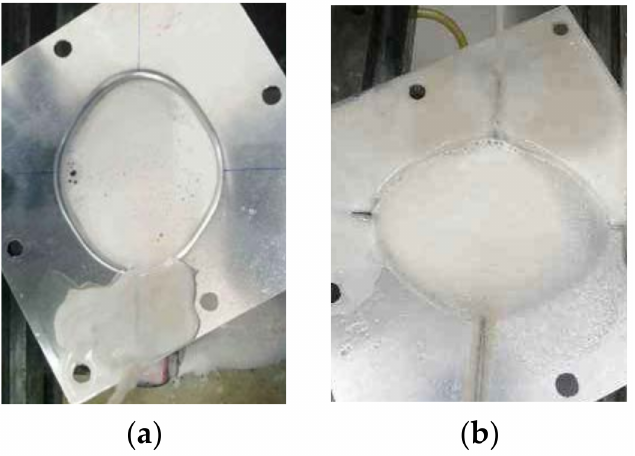
Figure 23. Cutting process: ( a ) the long axis direction cutting and ( b ) the short axis direction cutting.